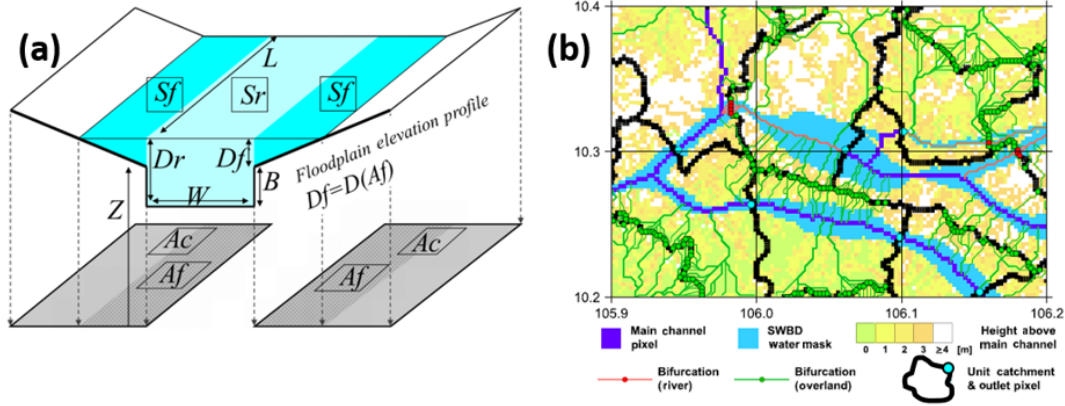
Figure 2. Schematic diagram of CaMa-Flood. (a) River channel and floodplain subgrid parameters (modified from Yamazaki et al., 2011). Please refer to Table 1 for definition of variables. (b) Subgrid topography and MDC channels. Overland pathways are represented by the green channels while river pathways are represented by the red channels (modified from Yamazaki et al.,